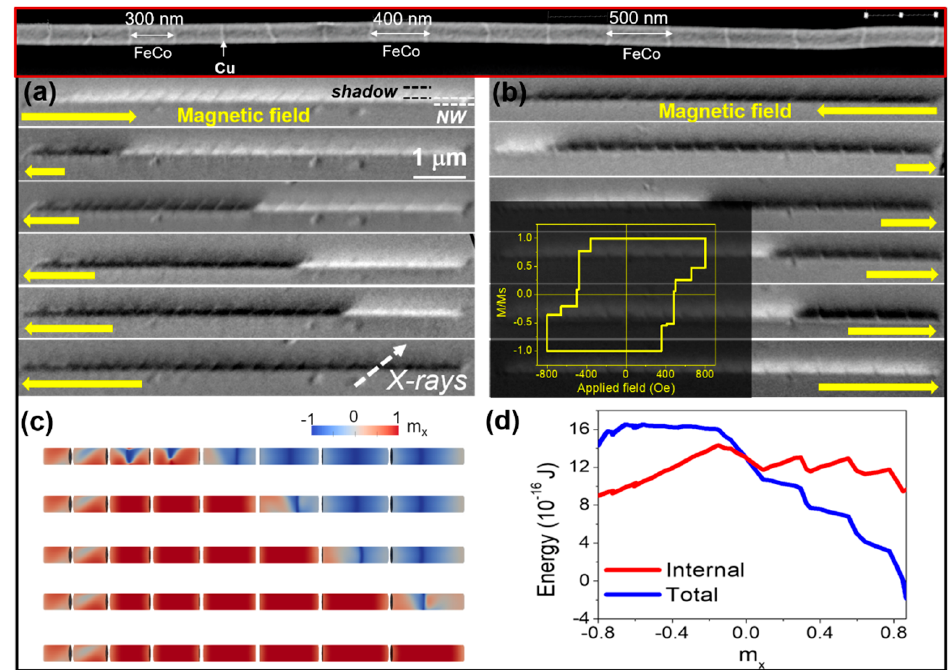
Figure 12. ( a , b ) Selected PEEM images under increasing applied field along the leftward ( a ) and rightward ( b ) polarity. The inset in ( b ) shows the reconstructed hysteresis loop. ( c ) Simulated magnetization configurations showing the sequential reversal during the reversal process. ( d ) Total and internal magnetic energies in FeCo/Cu nanowire as a function of the longitudinal magnetization component evaluated by the micromagnetic simulations during the ascending branch of the hysteresis loop. Adapted with permission from ref. [65]. Copyright 2018 American Chemical Society.